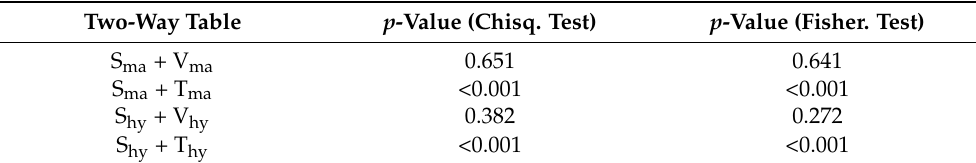
Table 3. Fisher’s exact and chi-squared test results based on the contingency table (visual assessment to stump assessment and tomograph assessment to stump assessment). Acronym explanations are given in the materials and methods chapter. Figure 4. Classification of sample trees according to decay assessment method and the association between the results obtained using the various methods: ( left ) comparison between the visual as- sessment and stump assessment; ( right ) comparison between the tomograph assessment and stump assessment. Blue color indicates that there are more observations in the cell than would be expected under the null model (independence). Red means that the cells show less than the expected fre- quency of observations [52]. Acronym explanations are given in the materials and methods chapter.